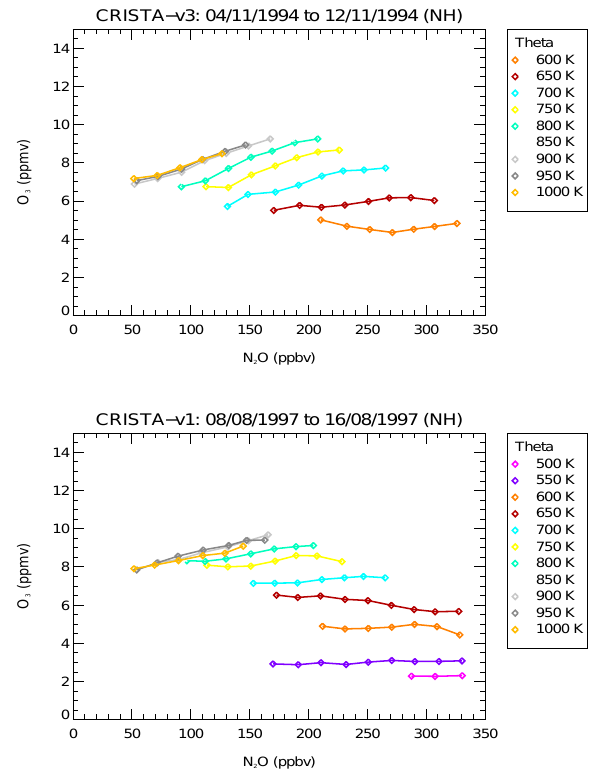
Fig.10. AveragesofN 2 OandO 3 derivedfromCRISTA-1measurementsforNovember1994(4 (cid:0) 12November Fig. 10. Averages of N 2 O and O 3 derived from CRISTA-1 mea- 1994)forpotentialtemperatureslevelsbetween600 (cid:6) 25and1000 (cid:6) 25K(top)andCRISTA-2measurements surements for November 1994 (4–12 November 1994) for poten- for August 1997 (8 (cid:0) 16 August 1997) for potential temperatures levels between 500 (cid:6) 25 and 1000 (cid:6) 25K tial temperatures levels between 600 ± 25 and 1000 ± 25K (top) (bottom)forthenorthernhemispheretropics(0 ◦ –30 ◦ ). and CRISTA-2 measurements for August 1997 (8–16 August 1997) for potential temperatures levels between 500 ± 25 and 1000 ± 25K (bottom) for the Northern Hemisphere tropics (0–30 ◦